Question: Describe this figure in one sentence.
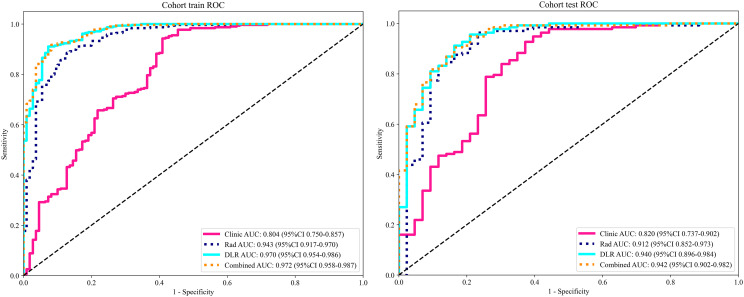
Answer: The AUCs of various prediction models in the training and validation cohorts.